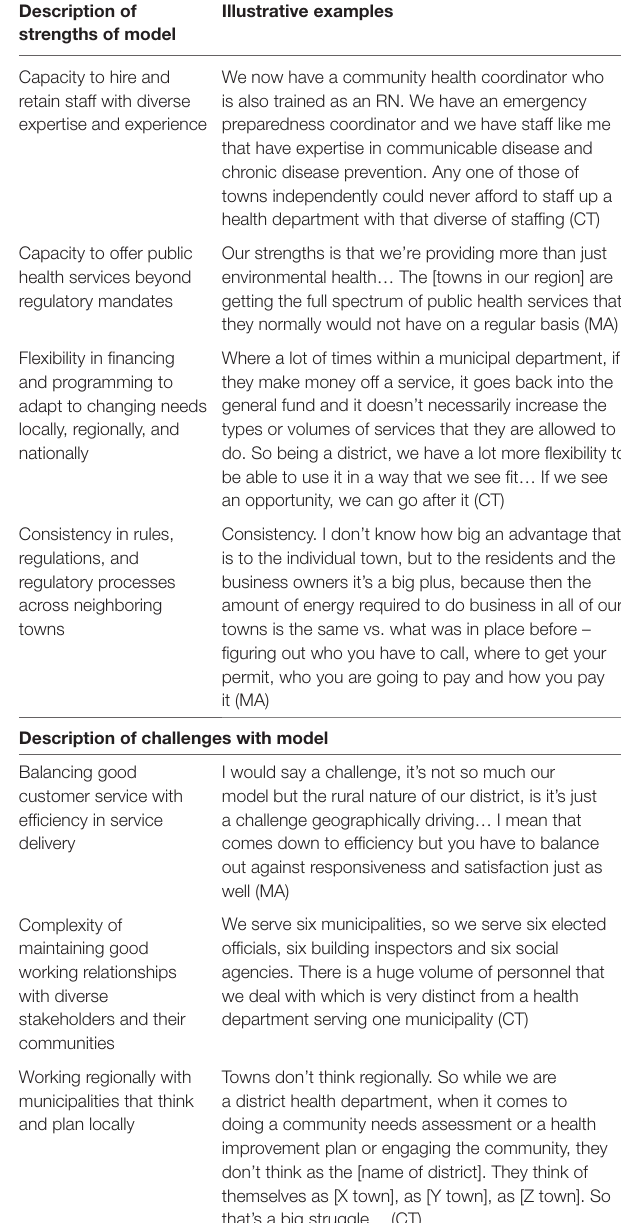
TaBle 2 | Perceived strengths and challenges of independent health department